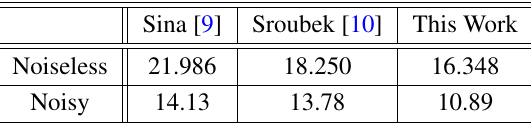
Table 3. PSNR values (in dB) for the restoration